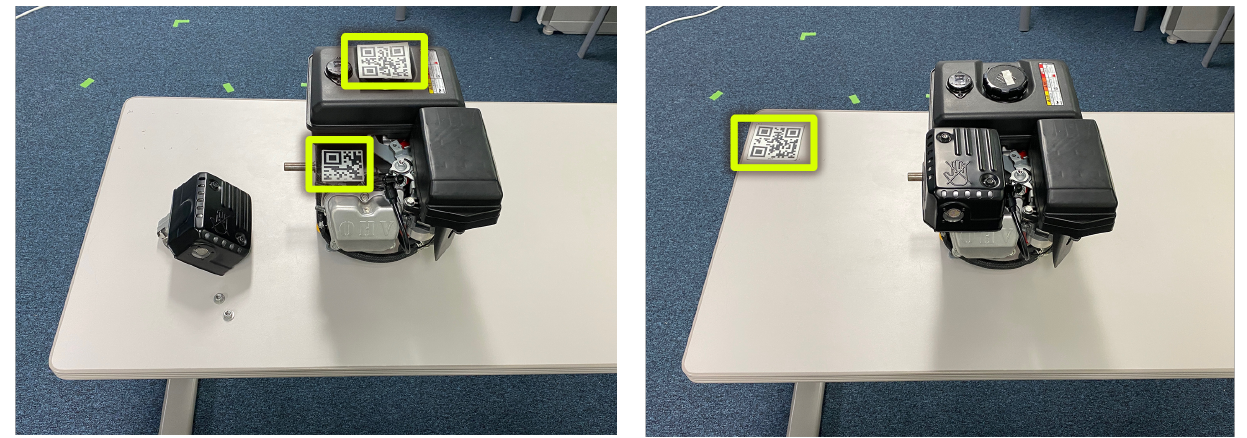
Figure 28. ( a ) The engine has two markers attached to different parts to ensure that objects are tracked throughout the entire process. ( b ) There is no marker on the engine, and the marker on the table is used to determine the coordinates of all virtual objects in the scene except for the main-panel.